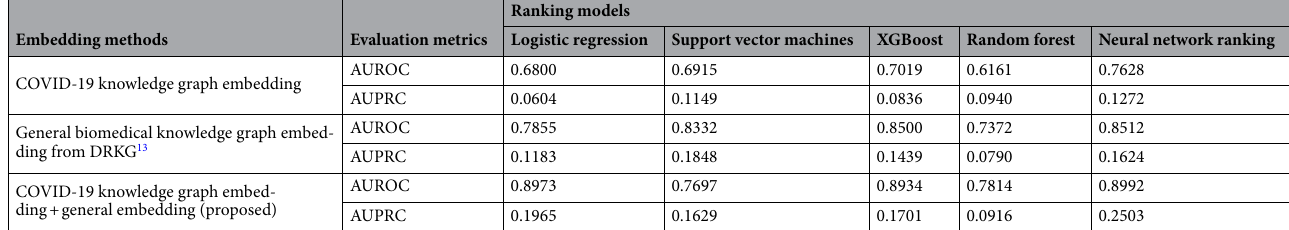
Table 1. Accuracy of predicting drugs under COVID-19 clinical trials. The predictors were the drug embedding and labels that were whether a drug is under clinical trials. Logistic Regression, Support Vector Machines, XGBoost, and Random Forest were off-the-shelf models. The neural network is a customized model ( Methods ). AUROC area under the receiver operating curve, AUPRC area under the precision-recall curve.